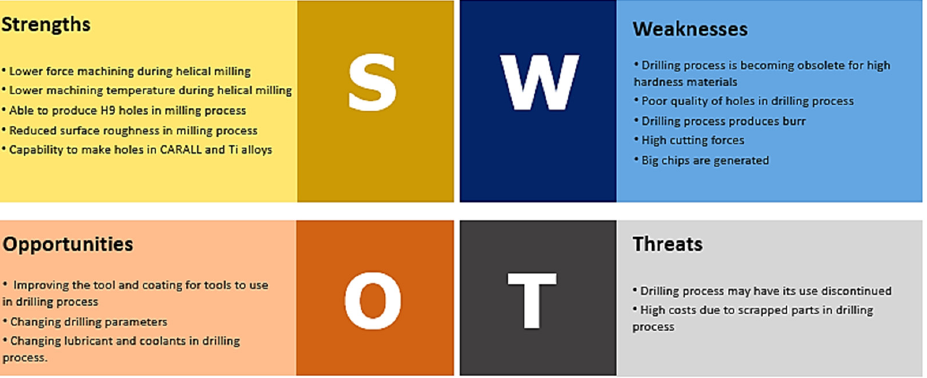
Figure 17. SWOT analysis obtained by comparing between drilling and milling processes in FML.